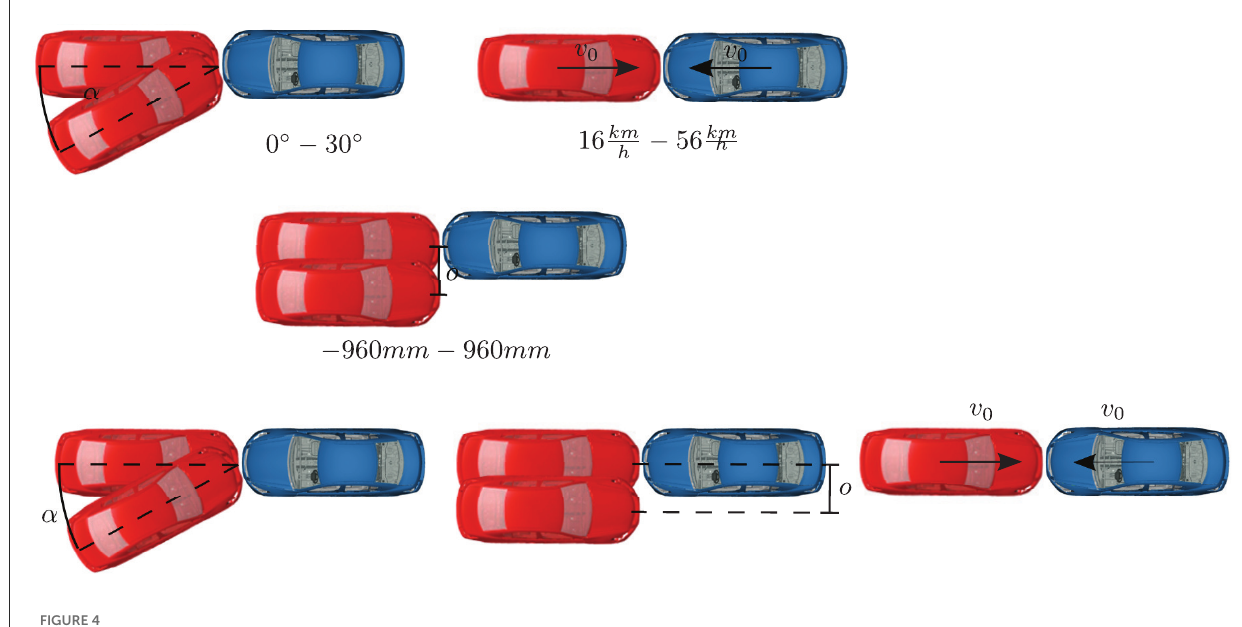
FIGURE4 Definition and parameter range of the collision configuration depending on the initial velocity, angle and offset. Two mid-size sedan Honda Accords (model year 2014) are used as ego (blue) and target vehicle